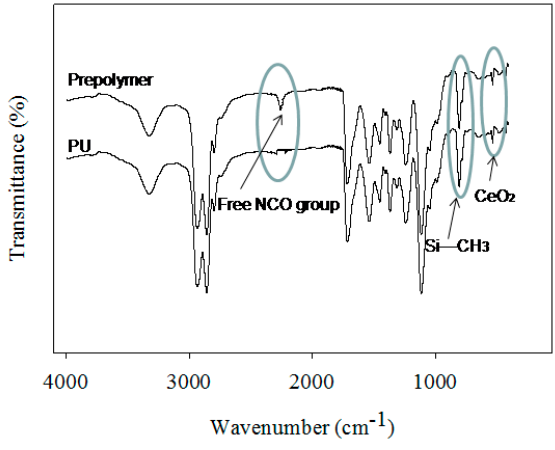
Figure 1. FT-IR spectra of PU-11-3-3-CeO 2 -P coating.